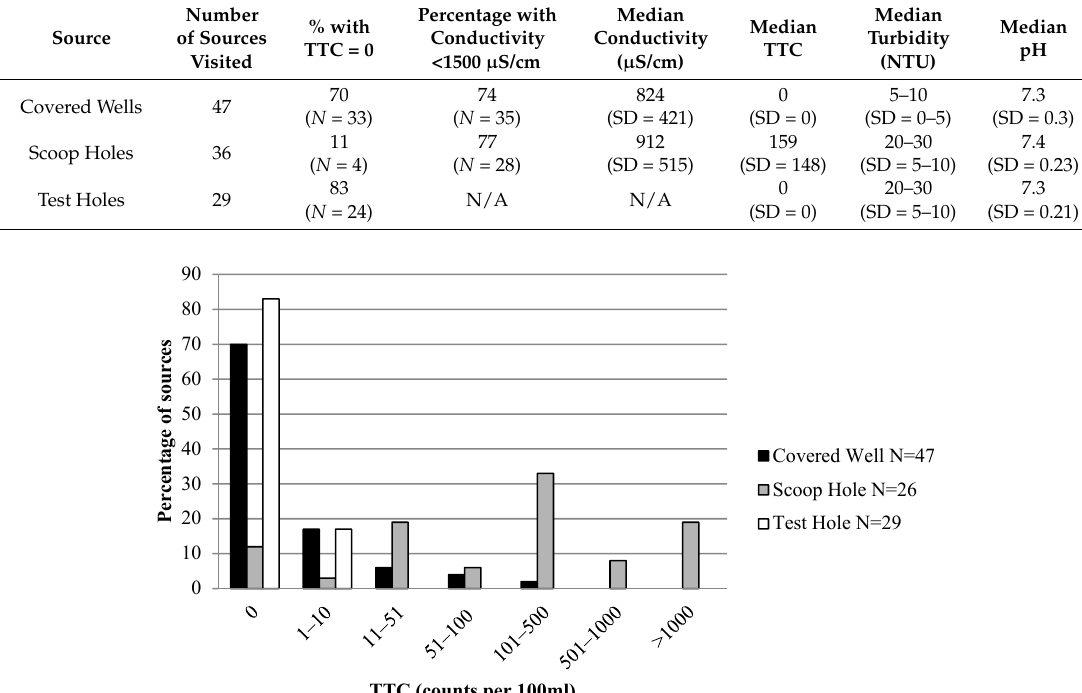
Figure 3. The histogram showing distribution of TTC measurements with different source types. KEBS [28] and WHO [27] guideline value is 0 TTC/100 mL.